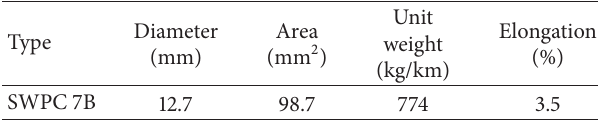
Table 1: Material properties of